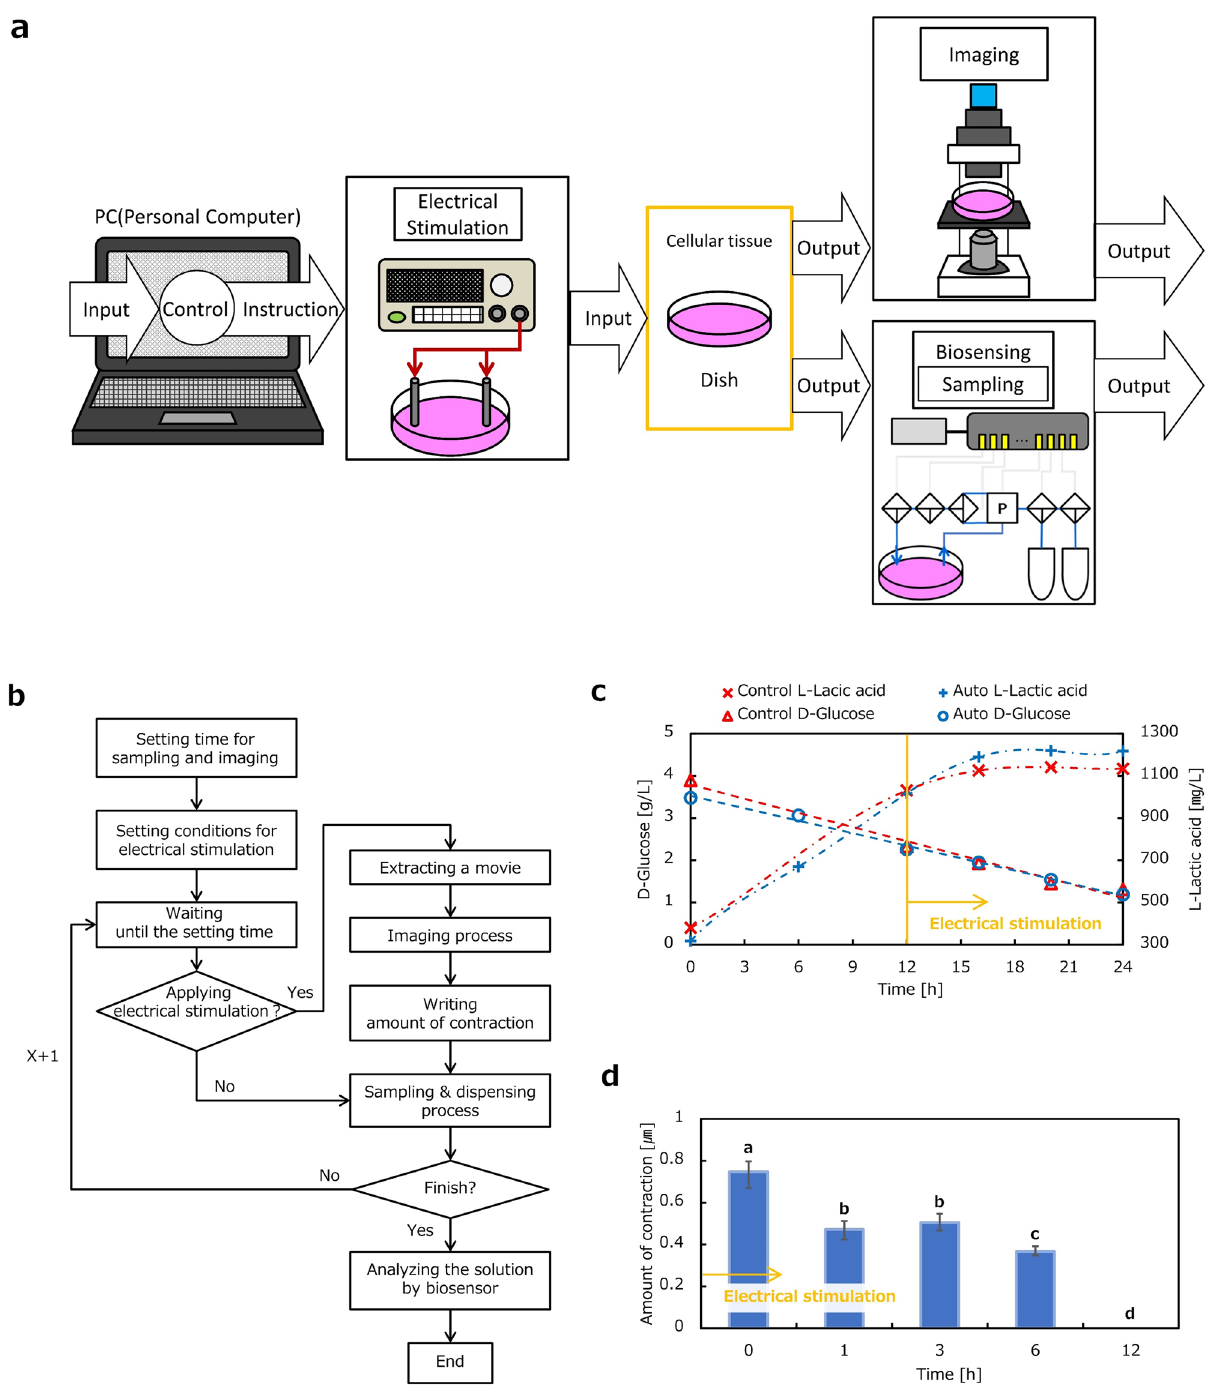
Figure 5. PC-controllable sampling, dispensing, analyzing of metabolite from the electrically stimulated SM cellular tissue together with imaging of its contraction. ( a ) A total system composition consisting of subsystems for culture, sampling and dispensing with an analyzer, electrical stimulation, and imaging. SM cellular tissue was electrically stimulated and evaluated by biosensing and imaging. The experiment was carried out for 24 h and electrical stimulation was applied after 12 h. ( b ) Flow chart of an algorism for PC-controllable imaging of SM cellular tissue contraction. ( c ) Measurement of d-Glucose in a culture media and l-lactic acid as a metabolite (n = 1). Electrical stimulation was likely to affect the concentration of l-lactic. ( d ) Evaluation of contraction of the SM cellular tissue by image processing. The average value of the flow vector was calculated as contraction of SM (n = 5). Contraction of SM cellular tissue showed stable value for several hours and decreased. Plots not connected by the same letter are significantly different from each other (one way ANOVA with Bonferroni comparisons, p <